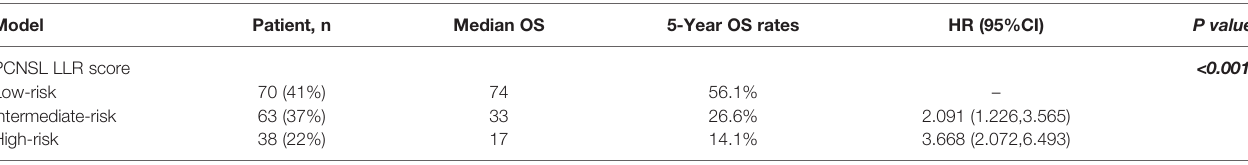
TABLE 6 | The novel PCNSL LLR scoring system.